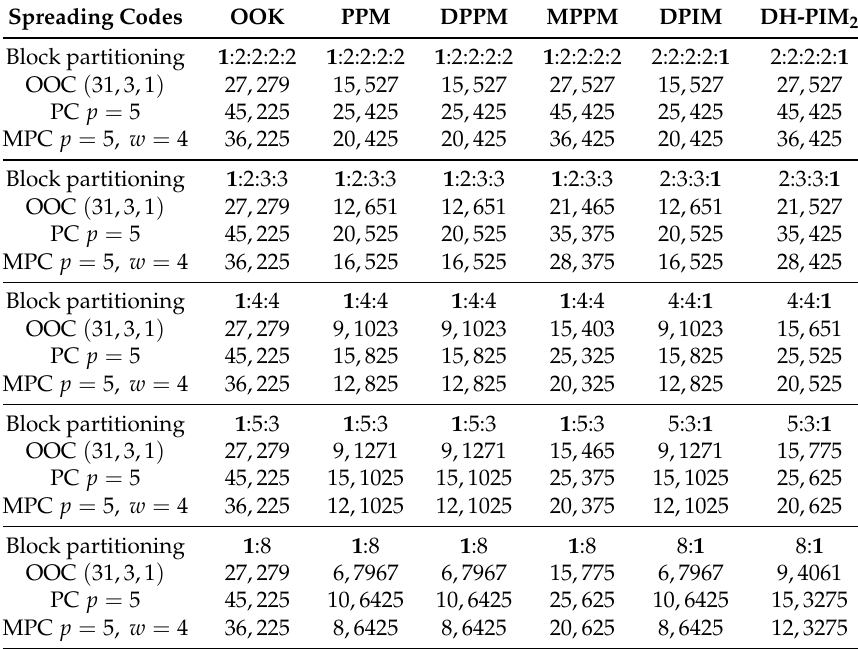
(cid:0) (cid:1) N p , L max .